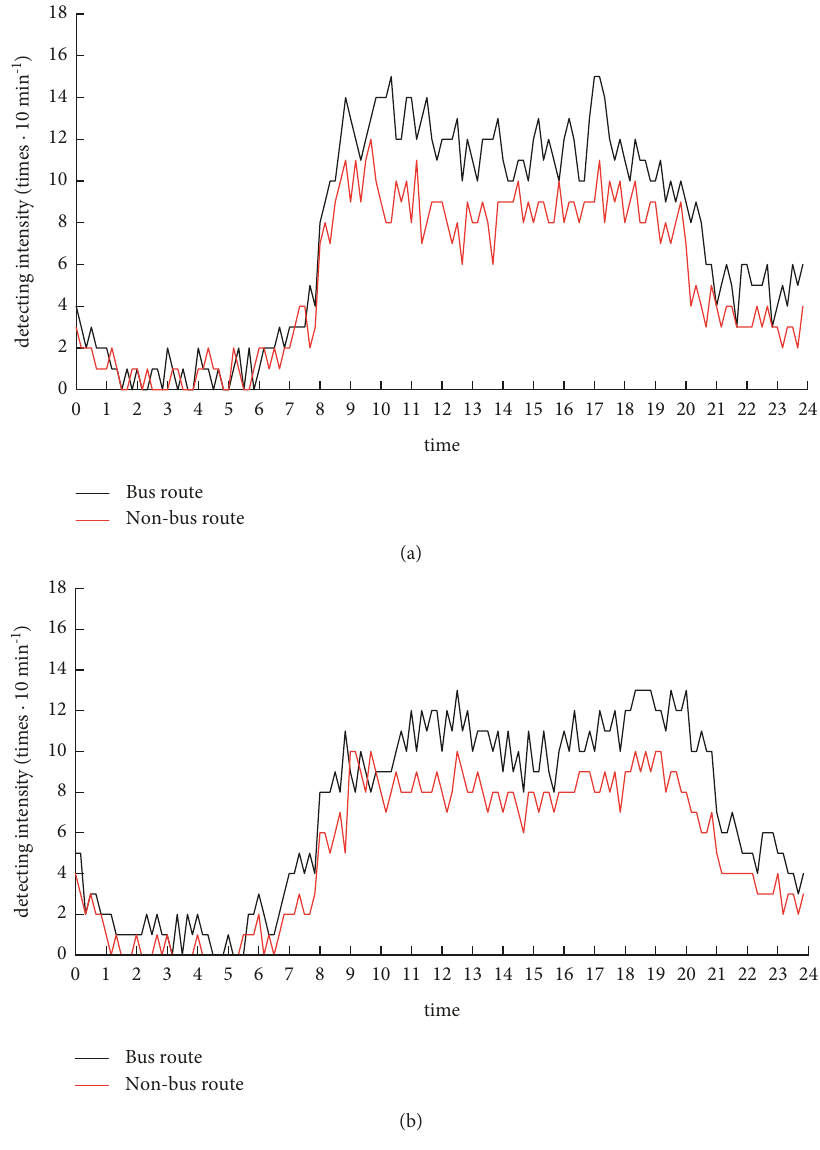
Figure 9: Average detecting intensity of ride-hailing vehicles on bus and non-bus routes. (a) Working day. (b) Holiday. Table 5: The travel times of ride-hailing vehicles on bus routes in Xuancheng. Area Numbers of road sections for bus